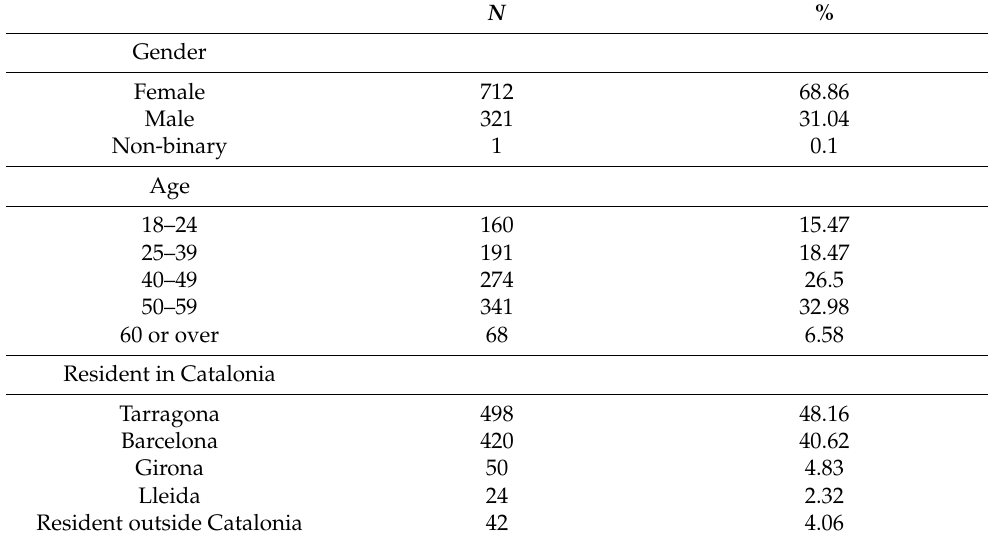
Table 1. Sample characteristics.